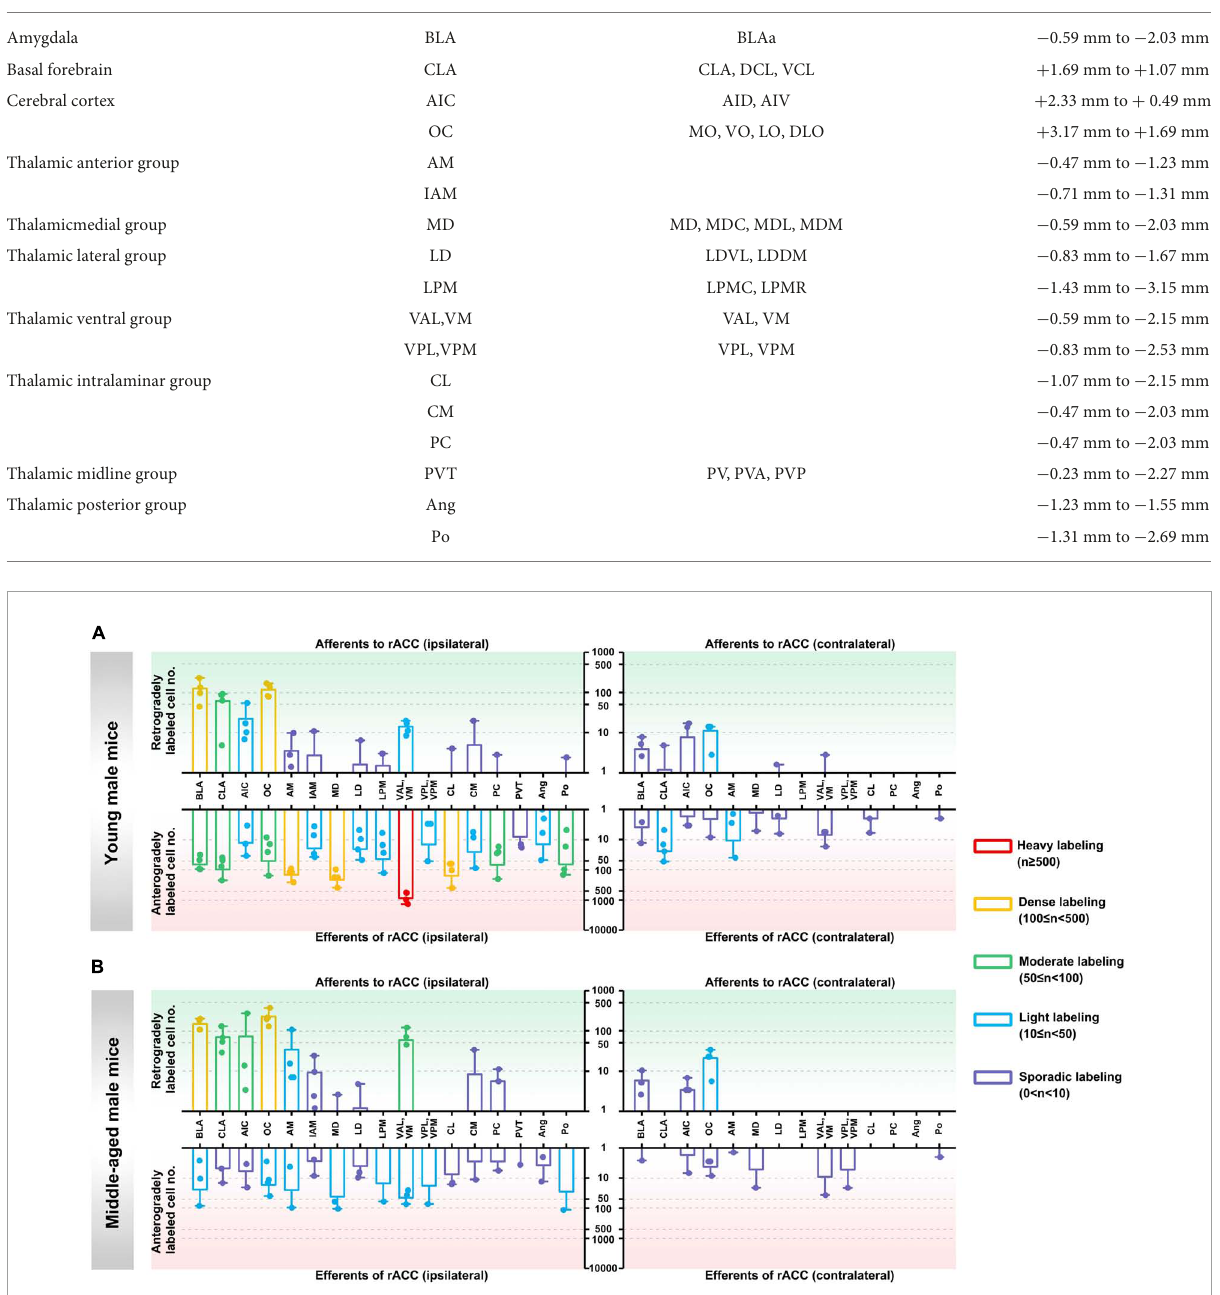
VAL/VM, VPL/VPM, and Po were sporadically labeled, while the remaining brain regions were not labeled ( Figure 2B , lower right